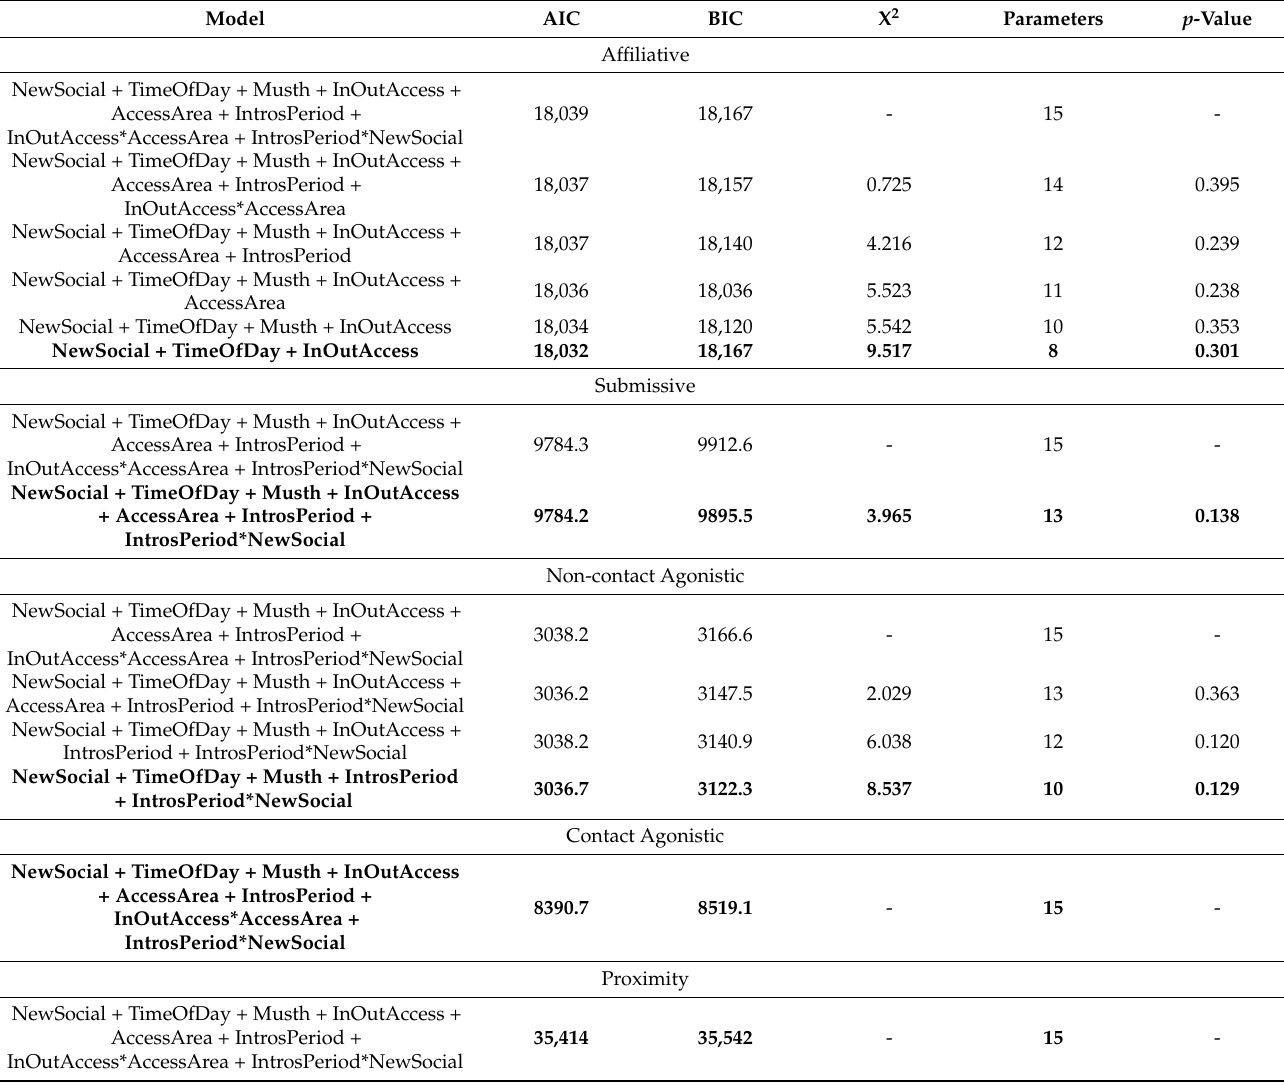
Table A3. Model selection table for GLMER of new social group behaviors (all data; bold indicates the final model selection). p -value from comparison to full model with